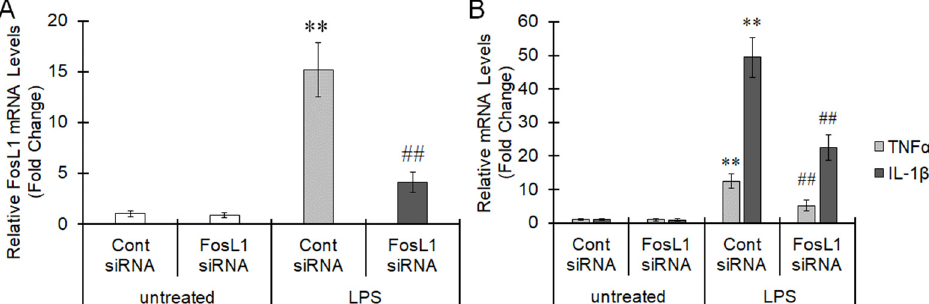
and the inflammatory reaction in BV-2 cells. When FosL1 siRNA was transfected into BV-